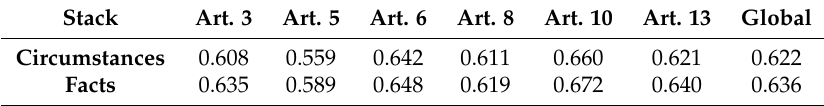
Table 8. Individual and global accuracies for the stack dataset (PLS + SVM